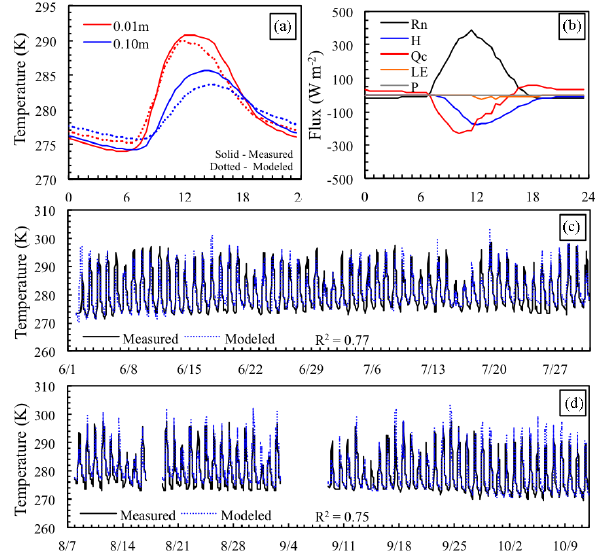
Figure 5. Various plots for Site 11 using the LE Rain model showing (a) average daily temperatures at two depths (solid and dashed lines indicate measured and modeled temperatures, respectively), (b) av- erage daily energy fluxes, (c) measured and modeled temperatures at a depth of 0.01m over the calibration period, and (d) measured and modeled temperatures over the validation